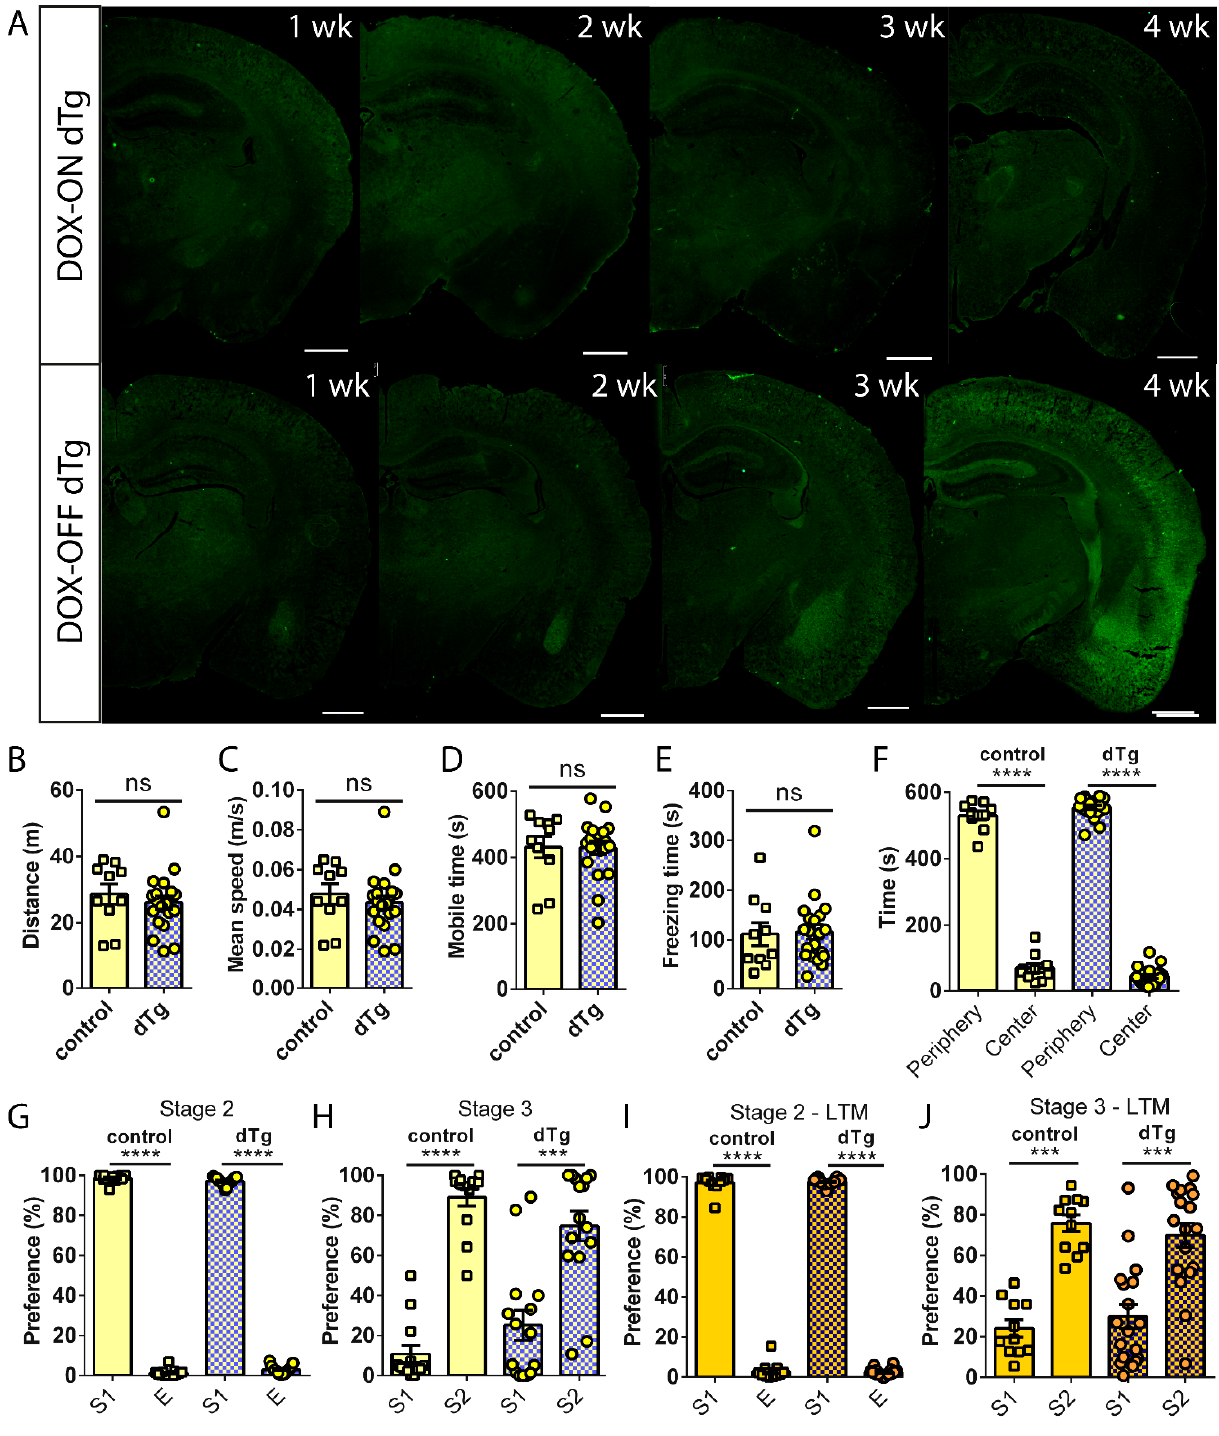
Figure 5. DOX administration rescues social recognition deficits in dTg animals without affecting basal locomotor activity. ( A ) The global expression of mPAK3-GFP proteins in dorsal coronal dTg half brain sections after the gradual administration and removal of DOX. Scale bar = 1000 µ m. ( B – F ) The locomotor and anxiety behavior of control and dTg mice during the open field test showing no significant differences after 4 weeks of DOX administration. No differences in ( B ) distance t (28) = 0.7009, p = 0.4891; ( C ) mean speed t (28) = 0.7231, p = 0.4756; ( D ) mobile time t (28) = 0.06681, p = 0.9472; ( E ) freezing time t (28) = 0.1653, p = 0.8699; and ( F ) time spent in periphery and center zones F (1,28) = 1379; p < 0.0001, post hoc control p < 0.0001, dTg p < 0.0001; between genotypes F (1,28) = 1.130; p = 0.2969, post hoc p = 0.1112) of the open field test. ( G ) Sociability was unaffected during stage 2 F (1,26) = 15911; p < 0.0001, post hoc control p < 0.0001, dTg p < 0.0001; between genotypes F (1,26) = 1.518; p = 0.2289, post hoc p = 0.0777, of the three ‐ chamber social interaction test while rescuing basal short ‐ term social recognition deficit during ( H ) stage 3 F (1,26) = 50.31; p < 0.0001, post hoc control p < 0.0001, dTg p = 0.0004; between genotypes